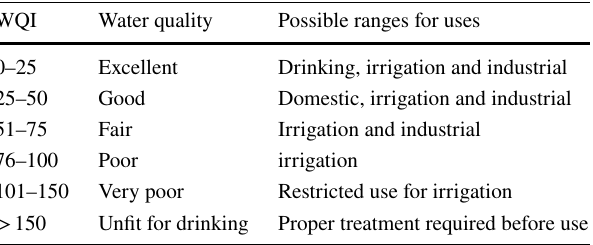
Table 1 WQI classification scheme for groundwater and possible ranges of use (Brown et al.1972; Ukah et al 2019a) WQI Water